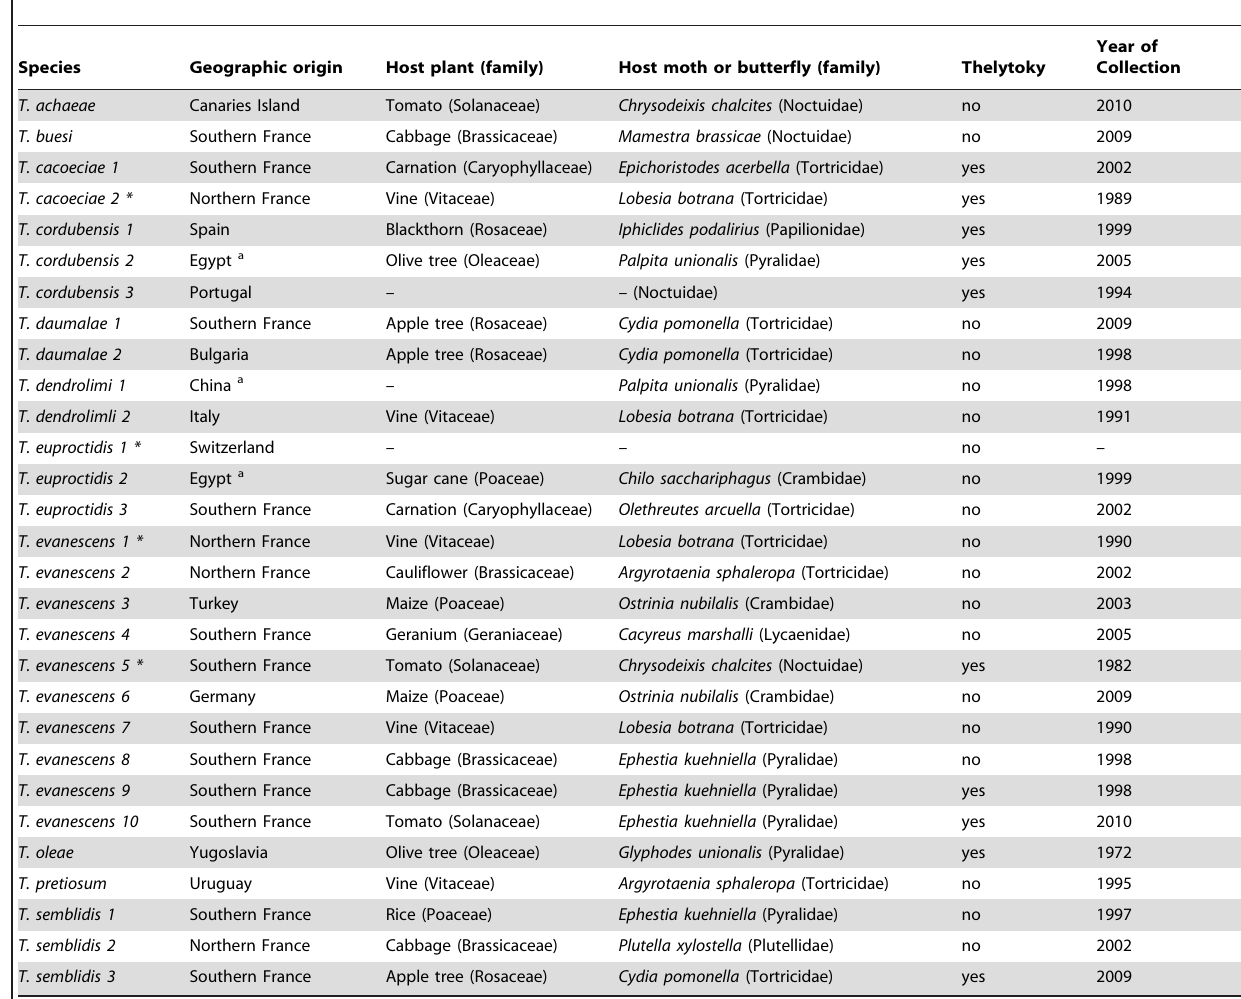
Table 1. Year of collection, initial host and host plant, country of origin and Thelythoky status (females produced from unfertilized) of the 29 Trichogramma strains